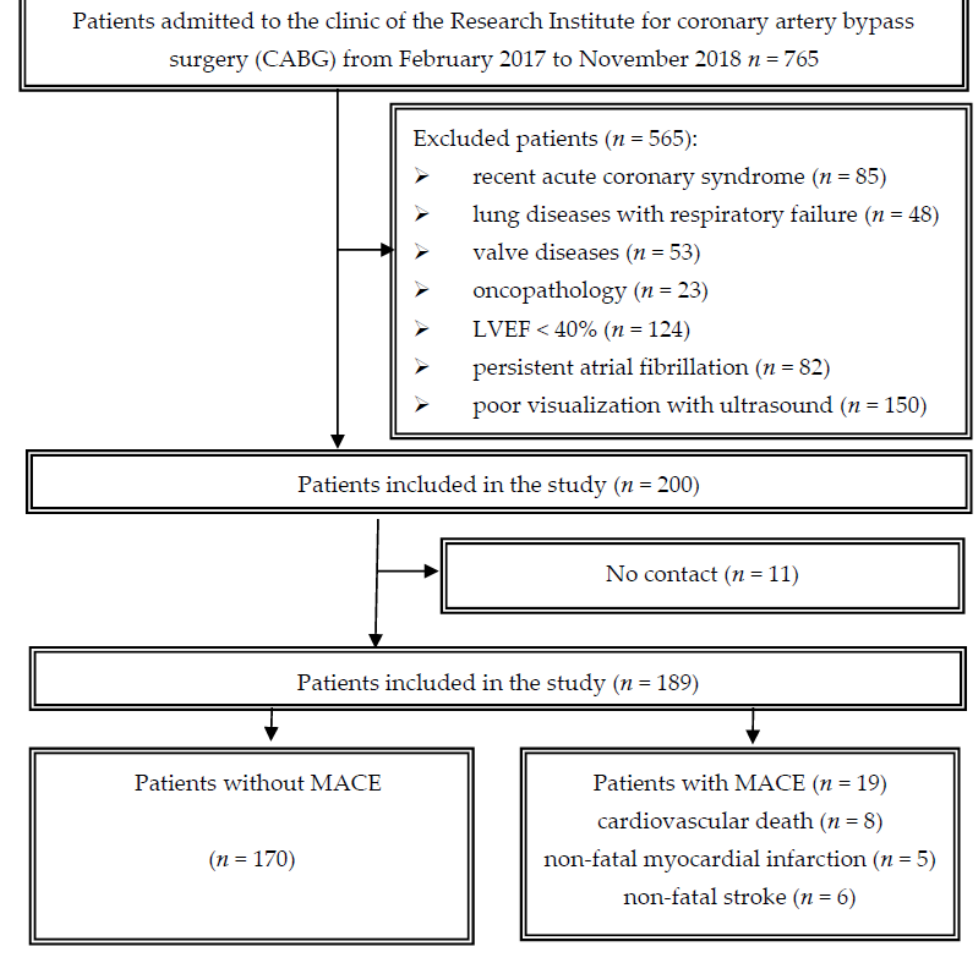
Figure 1. Study flowchart; MACE—major adverse cardiovascular event